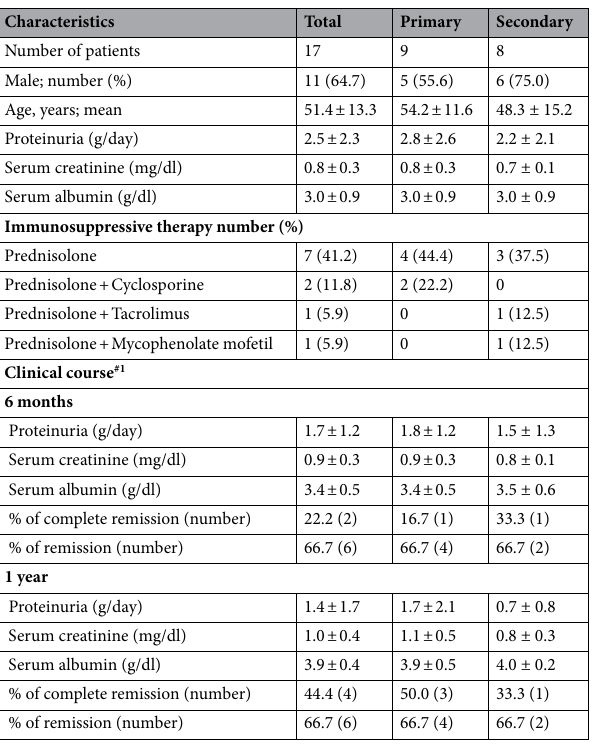
Table 5. Characteristics of Ext1/Ext2-associated MN in primary and secondary MN patients at the time of renal biopsy and treatment response. # 1; Follow up was done in our department in 6 and 3 patients of primary and secondary MN group,